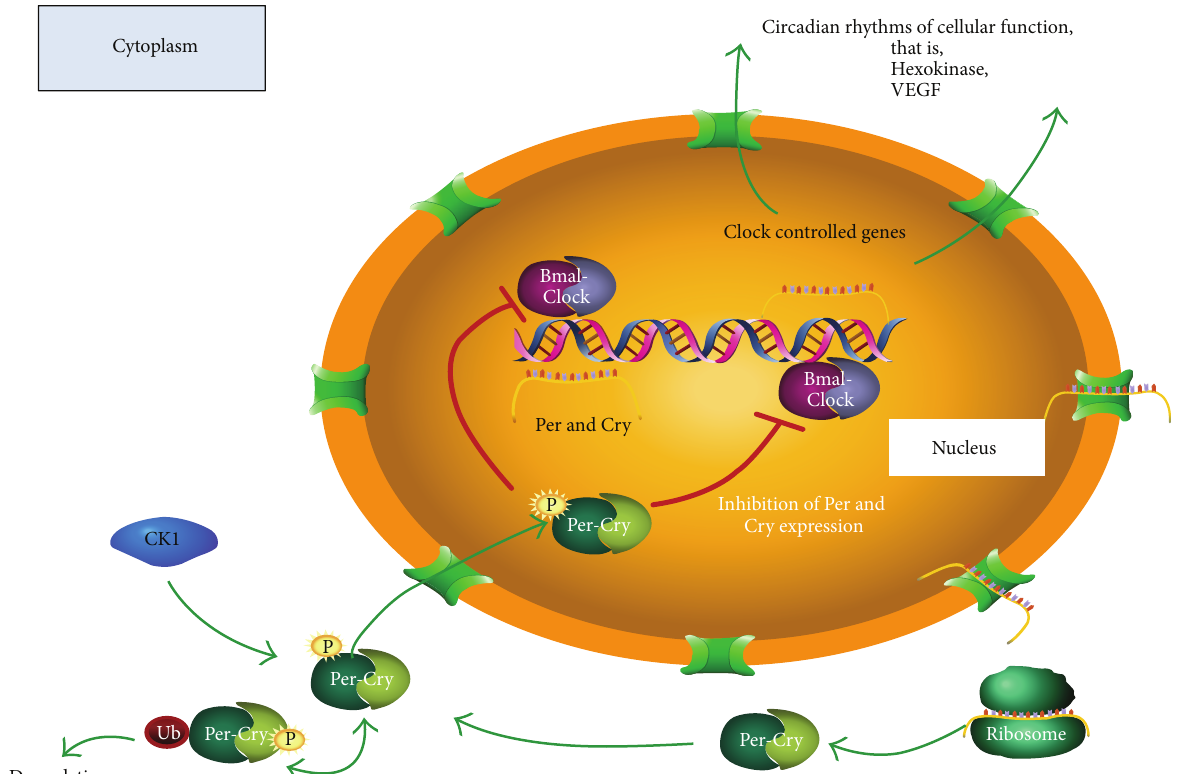
Figure 1: Molecular Circuit of Circadian Oscillator. See details in the text. Positive regulation of clock genes Bmal1 and Clock stimulate promoter of negative regulators Per 1-2, Cry 1-2 and controlled clock genes Hexokinase and